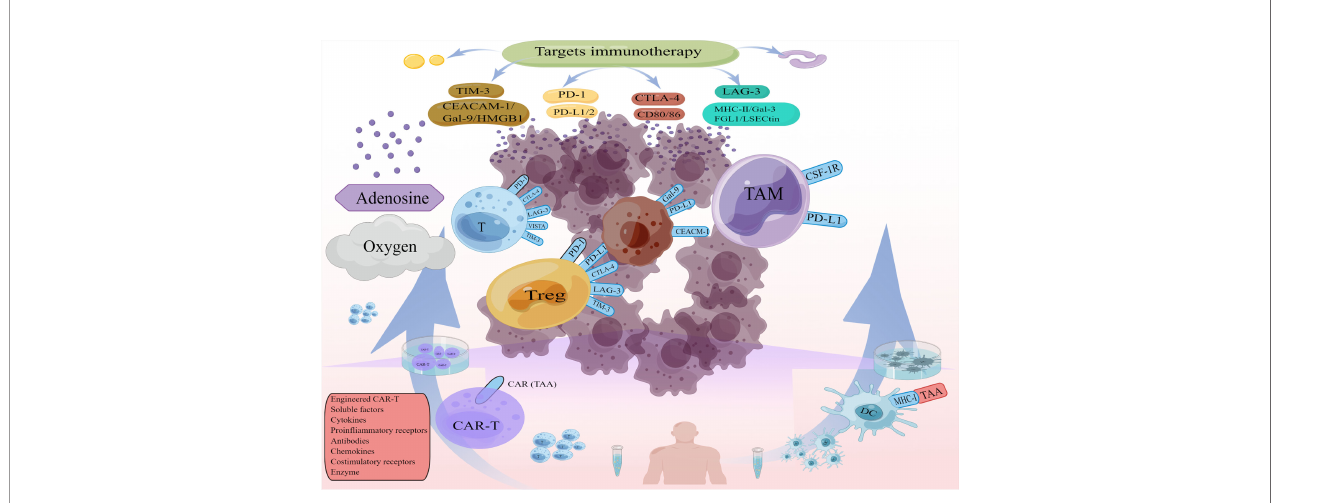
FIGURE 2 | Crosstalk of various treatments in TIME (By